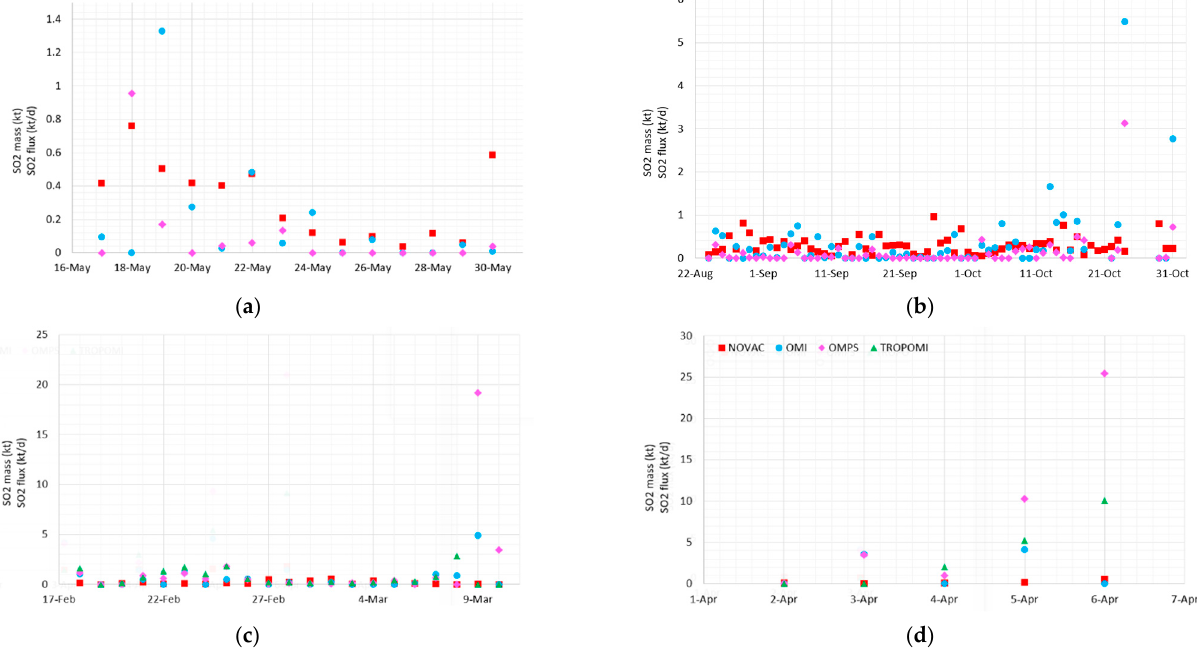
Figure 3. ( a – d ) Time series of TROPOMI (green triangle), OMPS (pink diamond), and OMI (blue circle) SO 2 mass comparisons vs. ground-based SO 2 fluxes from NOVAC network (red square) for the eruptions of interest. The uncertainty is 30% for all the instruments. ( a ) May 2015; ( b ) August–